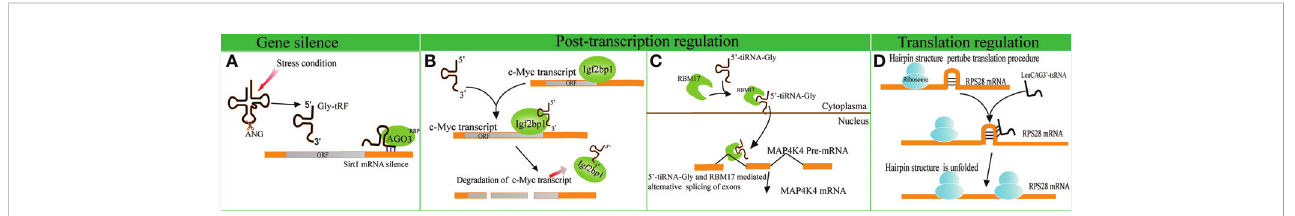
FIGURE 2 Gene expression regulation by tRNA-derived fragments (tRFs). (A) Gly-tRFs inhibit the expression of Sirt1 by associating with AGO3 to target Sirt1 mRNA 3 ′ -UTR. (B) 5 ′ -tsRNAs sequester RBP IGF2BP1 from the c-Myc mRNA and affects the stability of the target mRNA. (C) tiRNA-Gly promotes translocation of RBM17 from the cytoplasm to the nucleus, and induces RBM17-dependent splicing of MAP4K4 mRNA. (D) LeuCAG3 ’ -tsRNA promotes the translation ef fi ciency of ribosomal protein S28 ( RPS28 ) mRNA by unfolding the hairpin structure of RPS28